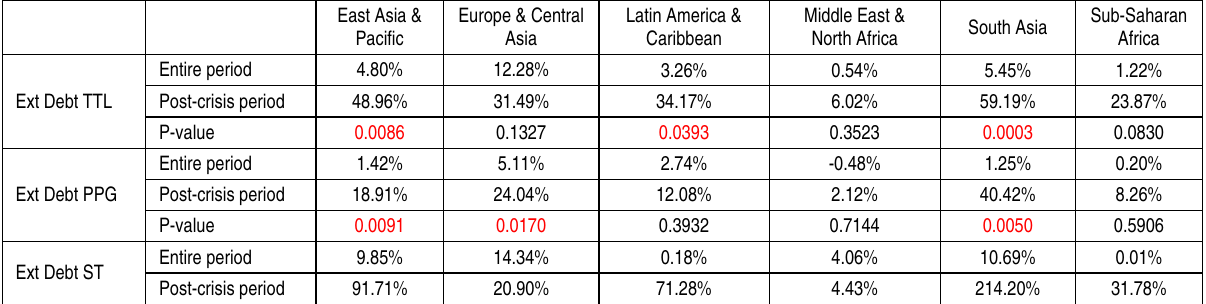
5 below. Table 5. Growth rates of total gross external debt, PPG external debt, ST external debt, and VR external